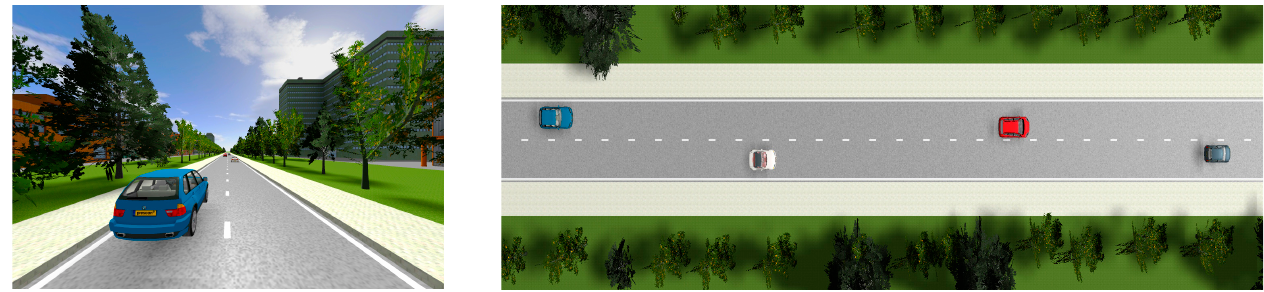
Figure 5. Training scenes.